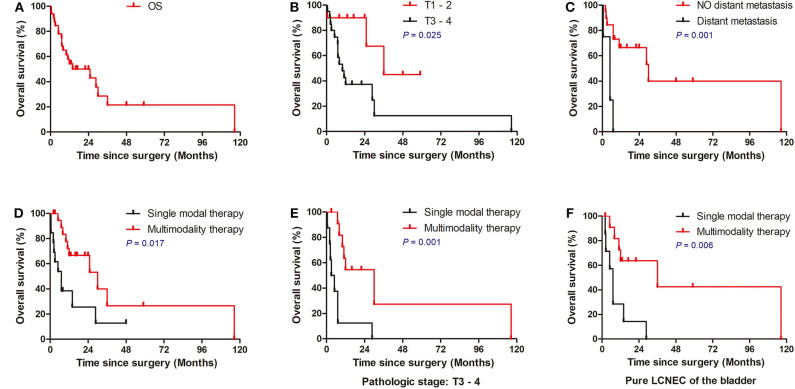
Overall Kaplan–Meier survival curves for patients with LCNEC. (A) Survival of all patients. (B) Survival of patients stratified according to TNM stage. (C) Survival of patients stratified according to T stage. (D) Survival of patients stratified according to M stage. (E) Multimodality therapy vs. single therapy according to pure LCNEC of the bladder. (F) Multimodality therapy vs. Single therapy according to pathologic stage T3–4. LCNEC, large cell neuroendocrine carcinoma; ACT, adjuvant chemotherapy.